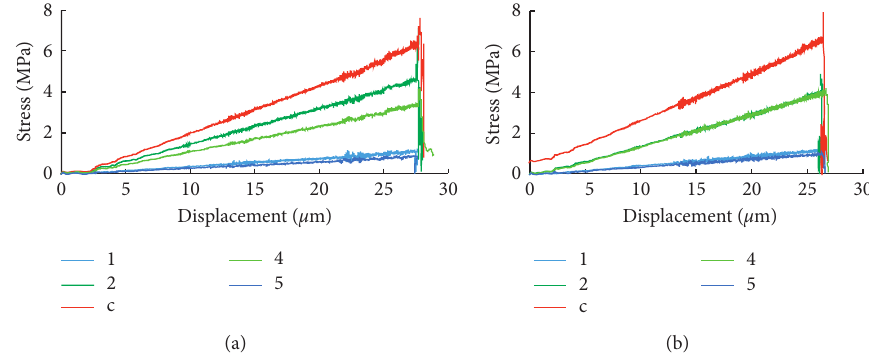
Figure 15: Stress-displacement curves of five monitoring points at different angles with uneven parallel bedding. (a) 15 ° . (b) 60 ° of beds on the left and right semidisk, respectively, of the shale model with uneven bedding.